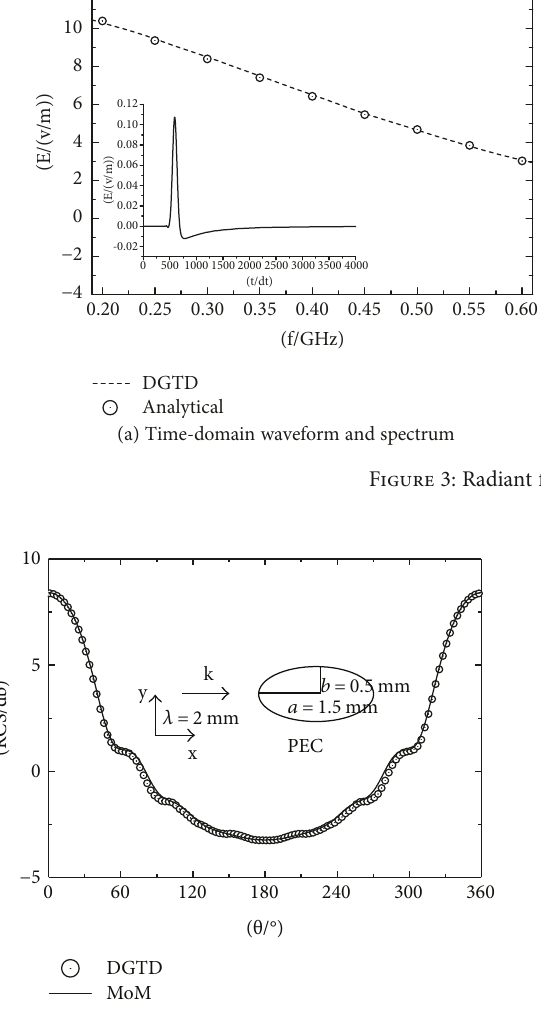
Figure 4: Bistatic RCS of PEC elliptic column.